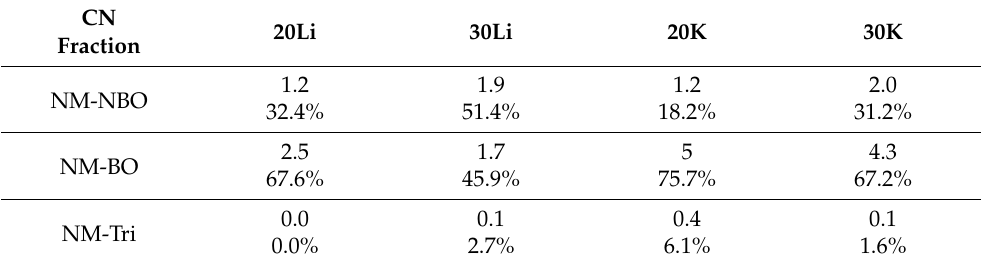
Figure 5. Overall fractions of non-bridging oxygen (NBO), bridging oxygen (BO), and tri-cluster oxygen ions (Tri) in the different chemical compositions. Table 4. Separation of NM-O coordination numbers (CN) into non-bridging oxygen (NBO), bridging oxygen (BO), and tri-cluster oxygen ions (Tri) and their